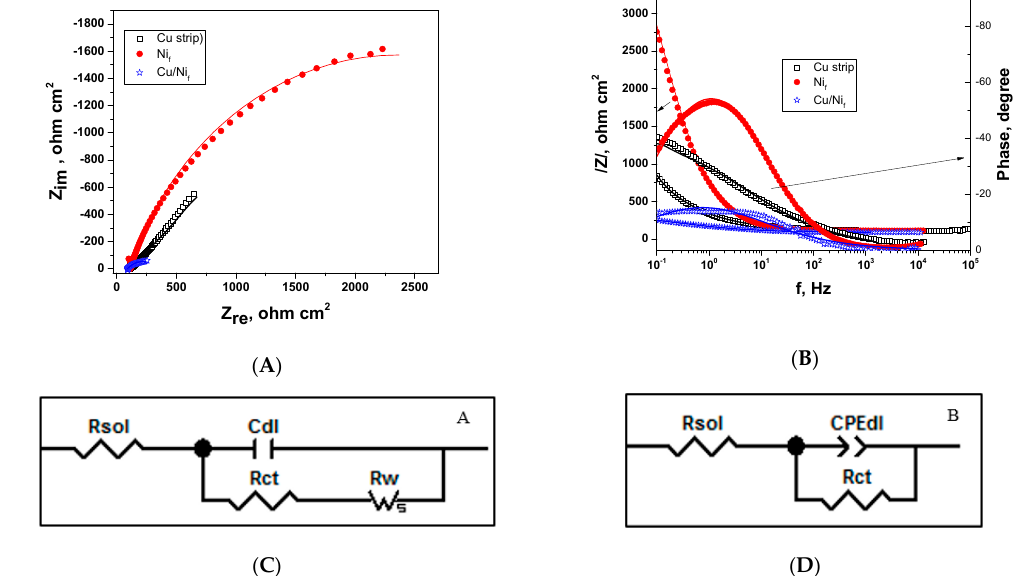
Figure 4. EIS data recorded in 5 mM [Fe(CN) 6 ] 3 ‒ /4 ‒ in 0.1 M NaOH solution for Cu strip, Ni f and Cu/Ni f electrodes as Nyquist ( A ) and Bode ( B ) plots. A and B represent the proposed equivalent circuit to fit the measured points. ( C and D )